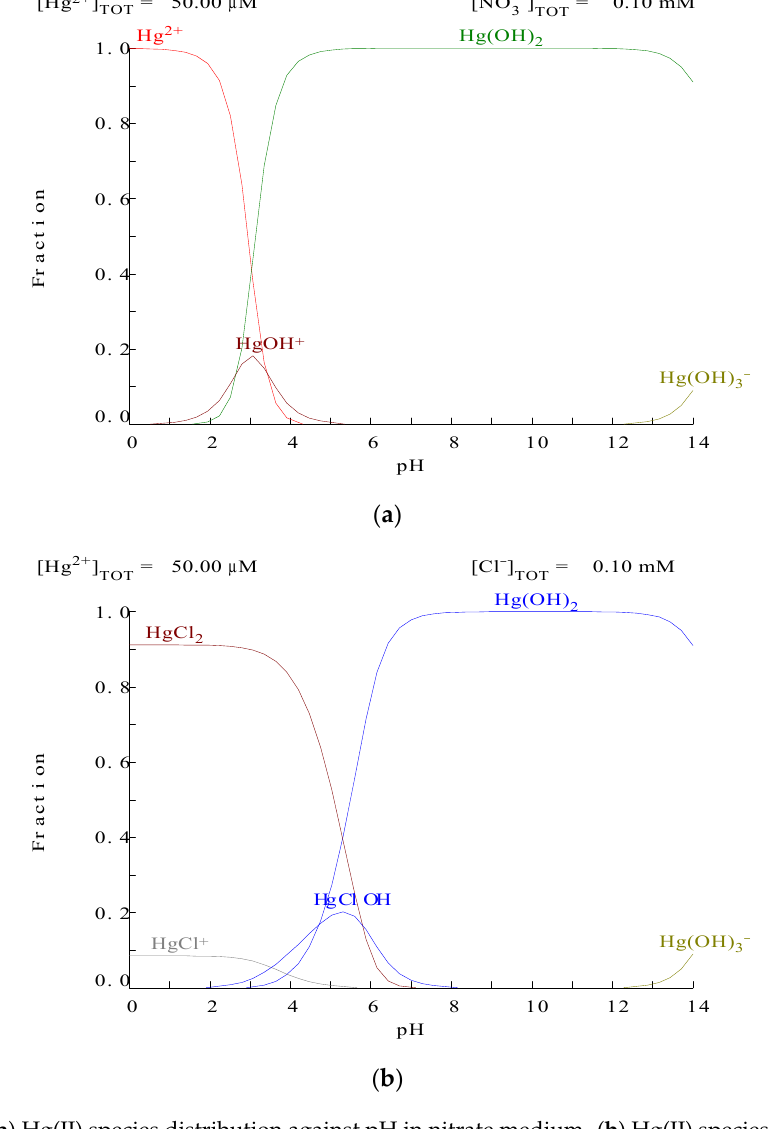
Figure 6. ( a ) Hg(II) species distribution against pH in nitrate medium. ( b ) Hg(II) species distribution against pH in a stoichiometric 1:2 (Hg 2+ :Cl − ) medium.